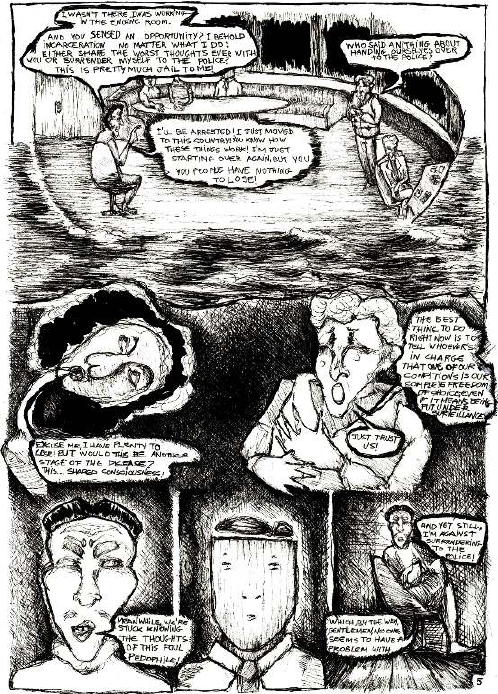
Credits: Amine Barbuda.